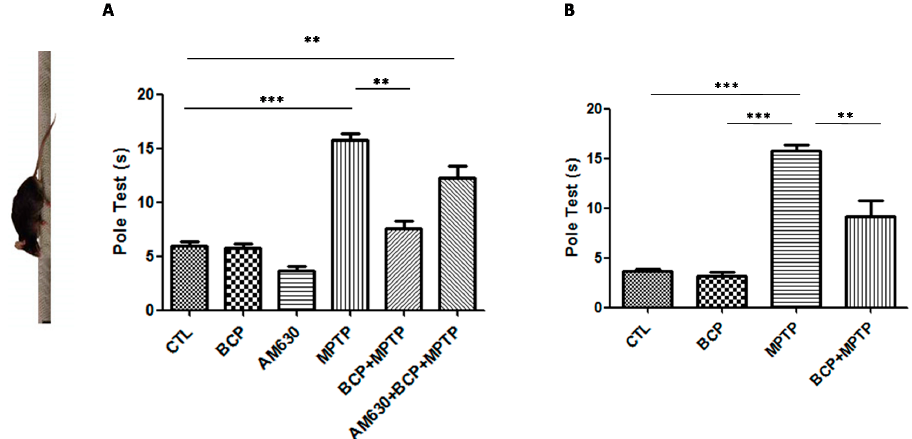
Figure 1. The pole test. The protective effects of BCP administered both intraperitoneally ( a )